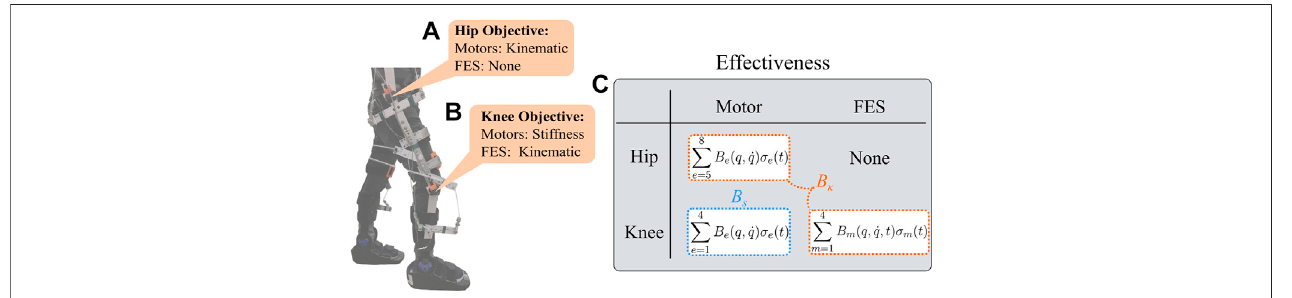
FIGURE 4 | Schematic of the kinematic ( κ ) and stiffness ( s ) control tracking objectives. (A) The hip joint is actuated only by the electric motors to achieve kinematic tracking (i.e., no FES is applied). (B) The knee joint is controlled to achieve both control objectives: electric motors track the stiffness objective and the muscles track the kinematic objective. (C) The table shows the control effectiveness matrices associated with the kinematic and stiffness control objective, B κ and B s ,